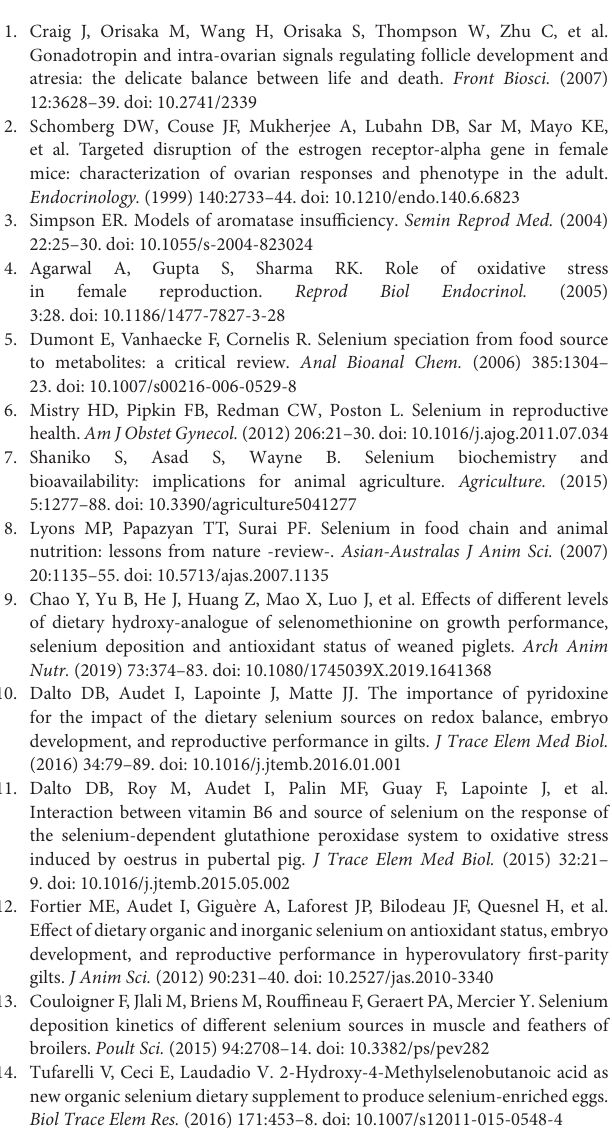
5. Mean values with different superscript letters were significantly different ( p < 0.05). Control, basal diet; Na 2 SeO 3 , 0.3mg Se/kg Na 2 SeO 3 ; HMSeBA, 0.3mg Se/kg HMSeBA; ADG, average daily bodyweight gain; ADFI, average daily feed intake. Supplementary Table 4 | Effects of dietary selenium supplementation on the development of reproductive tracts and internal organs of gilts. Data are expressed as means values and standard error, n = 5. Control, basal diet; Na Supplementary Table 5 | Effects of dietary selenium supplementation on the hormone concentration in gilts. Data are expressed as means values and standard error, n = 5. Control, basal diet; Na 2 SeO 3 , 0.3mg Se/kg Na 2 SeO 3 ; HMSeBA, 0.3mg Se/kg HMSeBA; LH, luteinizing hormone; FSH, follicle stimulating hormones; E 2 ,